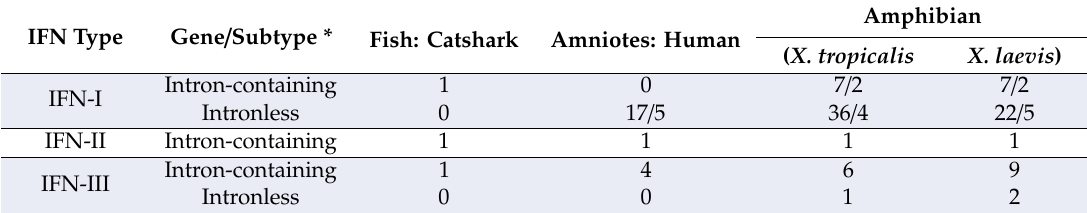
Table 1. Molecular composition of amphibian IFN complex compared with IFNs in amniotes (human) and fish